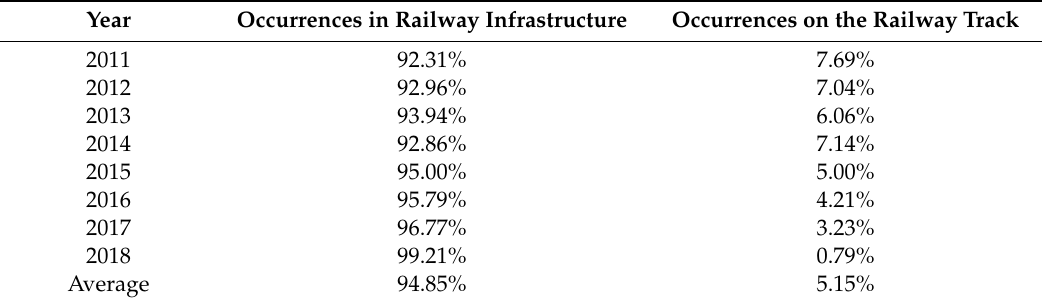
Table 4. Ratio of occurrences emerging from the railway tracks and at railway stations.